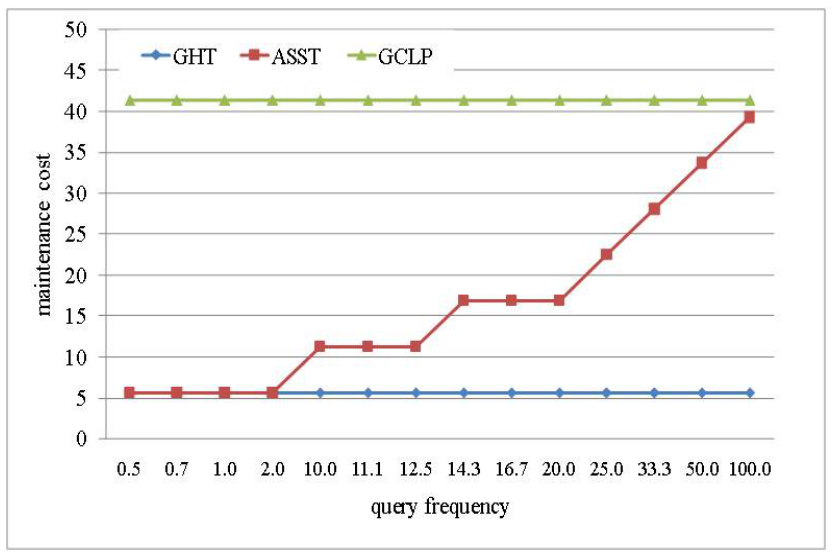
Figure 11. Energy consumption for storage